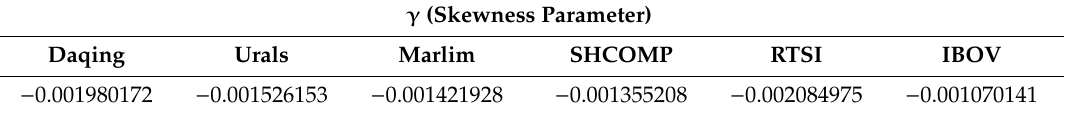
Table A8. MNIG Skewness parameter γ for Vector 2: Daqing, Urals, Marlim, SHCOMP, RTSI, IBOV. γ (Skewness Parameter)